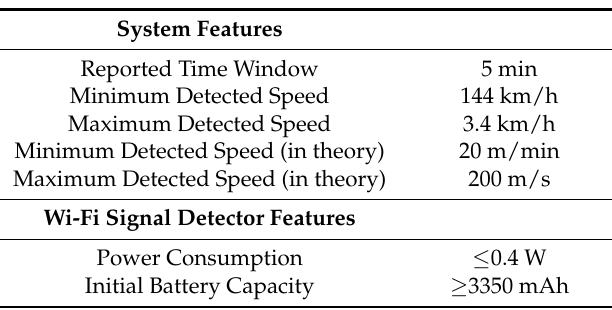
Table 5. Specification table of the proposed system and IoT-based Wi-Fi signal